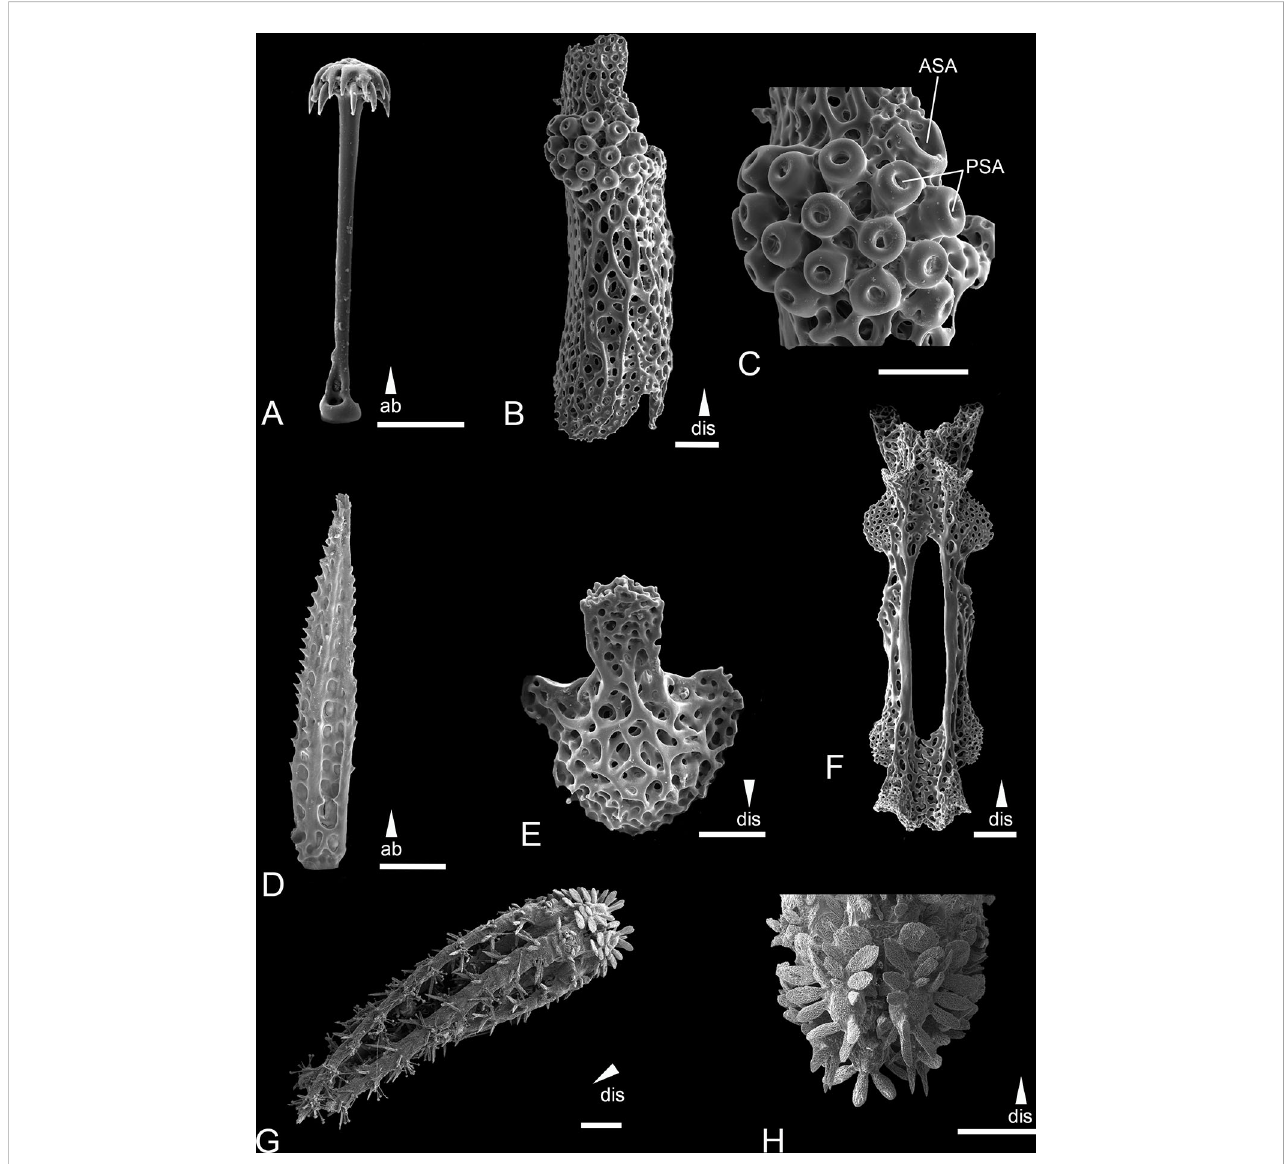
FIGURE 7 Scanning electron microscope images of the ossicles from Ophiotholia saskia sp. nov. (Holotype; SMF6909). (A) : Parasol-spine; (B) : Lateral arm plate; (C) : Close up lateral arm plate; (D) : Arm spine; (E) : Ventral arm plate; (F) : Arm Vertebrae; (G) : Habitus; (H) : Jaws. Scales: 50 µm (C) ; 100 µm (A, D, E) ; 200 µm (B, F) ; 500 µm (H) ; 1 mm (G) . ab, abradial; ASA, arm spine articulation; dis, distal; PSA, parasol spine